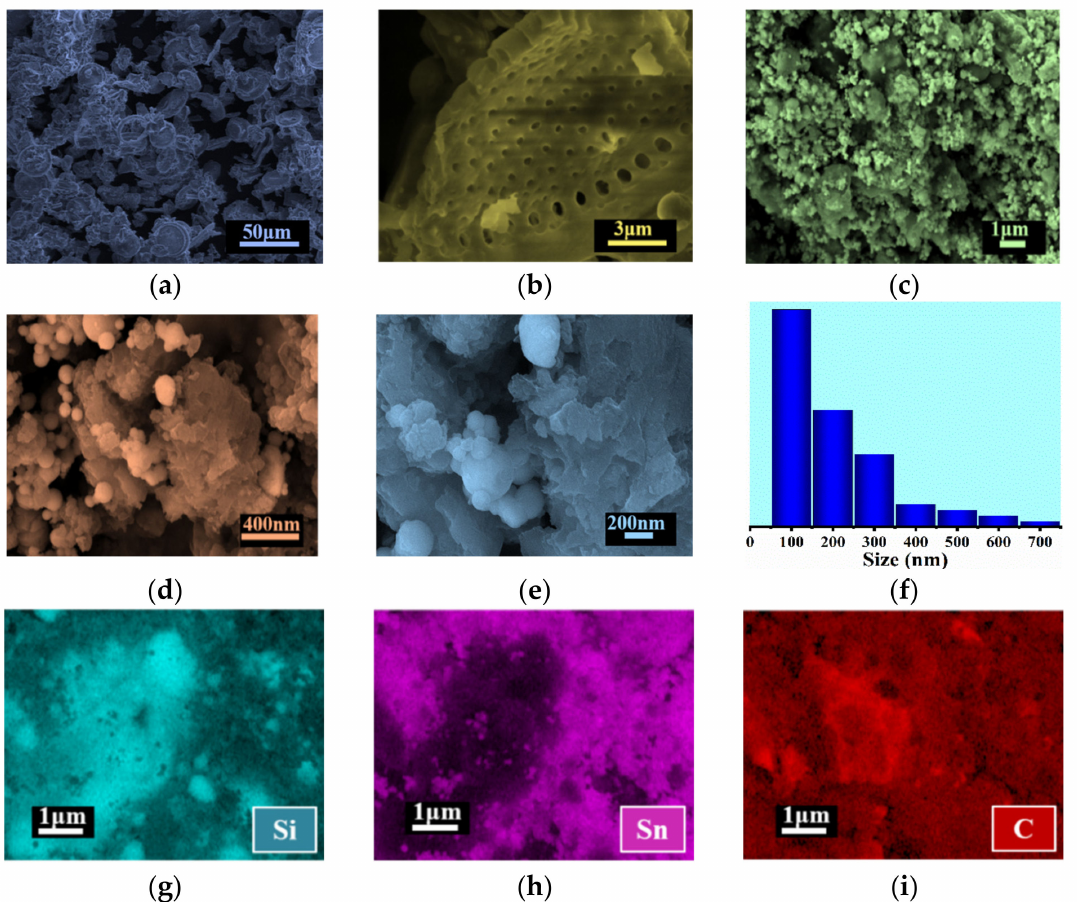
Figure 3. ( a , b ) SEM of bare SiO 2 with different magnification; ( c – e ) SEM of SiO 2 @Pc@Sn with different magnification; ( f ) size distribution for Sn in the SiO 2 @Pc@Sn composite; ( g , i ) element mapping of SiO 2 @Pc@Sn for Si ( g ); Sn ( h ); and C ( i